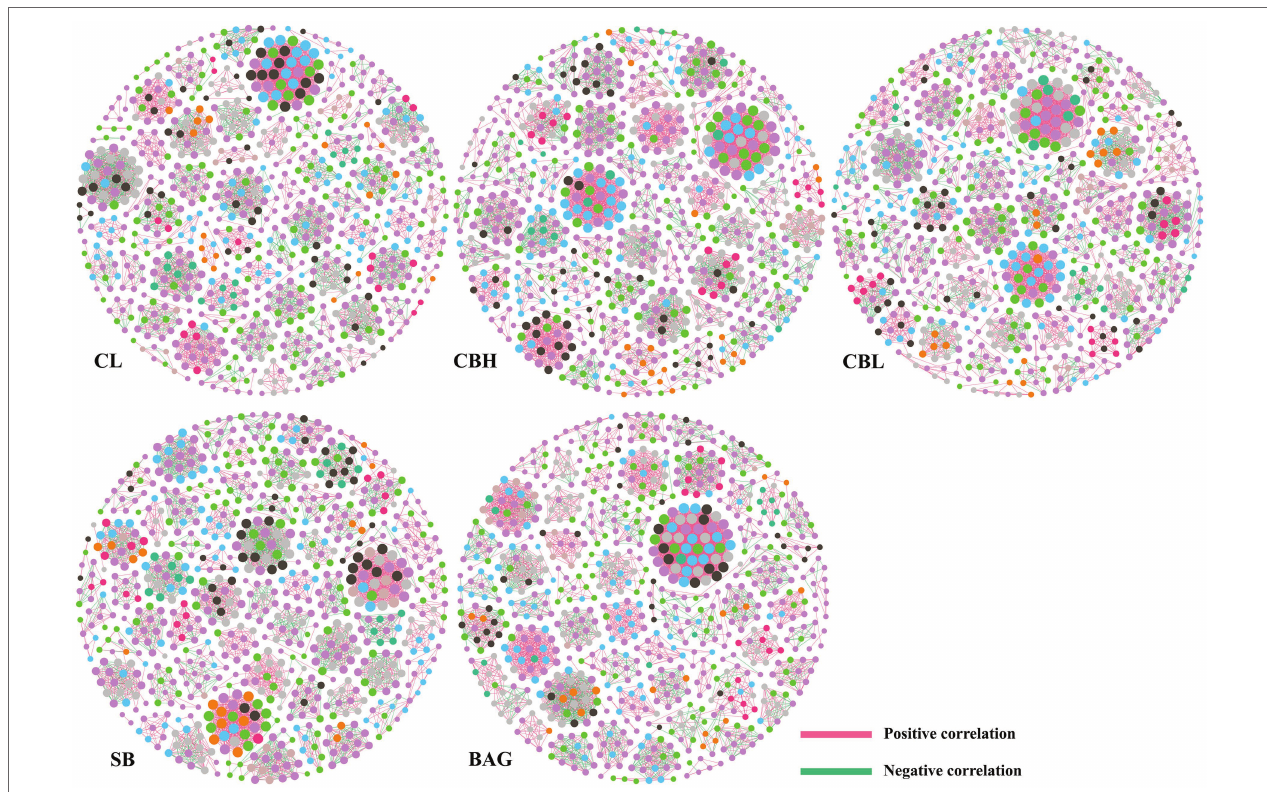
FIGURE 5 | Co-occurrence networks of microbial communities at OTU level. A connection stands for a very strong (Spearman’s R > 0.6) and significant (FDR- adjusted p < 0.05) correlation. The size of each node is proportional to the relative abundance; the thickness of each connection between two nodes (edge) is proportional to the value of Spearman’s correlation coefficients. Pink lines represent significant positive correlations, and green lines denote negative